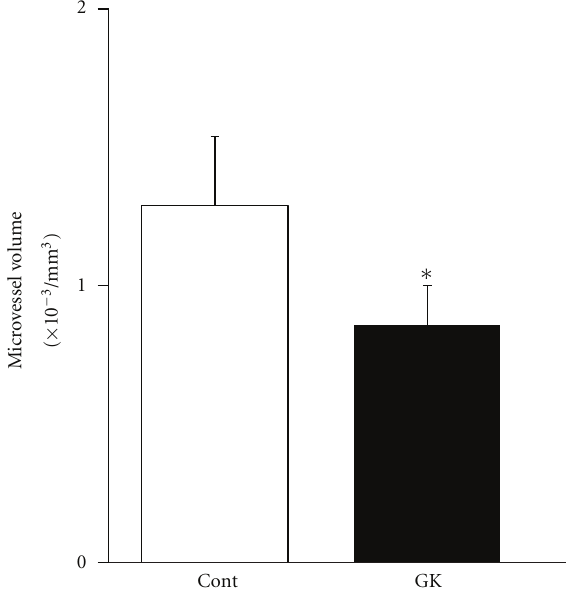
Figure 7: Data from the morphological measurement of the CLSM images by the NIH Image software. The mean microvessel volume of the GK rats was significantly lower than that in the Cont rats. ∗ P < 0 .